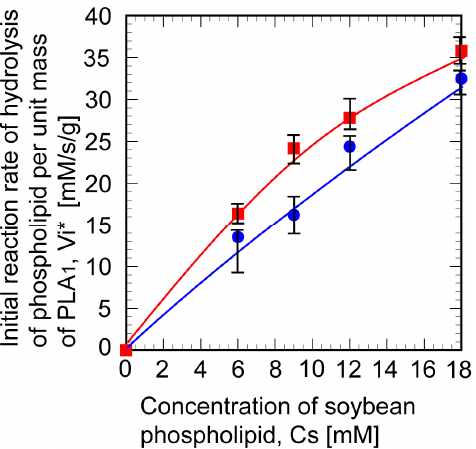
Figure 8. Relationship between the substrate concentration and the initial reaction rate for non- immobilized phospholipase A 1 in W/O microemulsion ( ■ ) at Hb = 0.3 mL, immobilized phospho- lipase A 1 ( ● ) at Hb = 0.075 mL. The concentration of glutaraldehyde for immobilization was 6%. Vi*: initial reaction rate of hydrolysis of phospholipid per unit mass of PLA 1 .